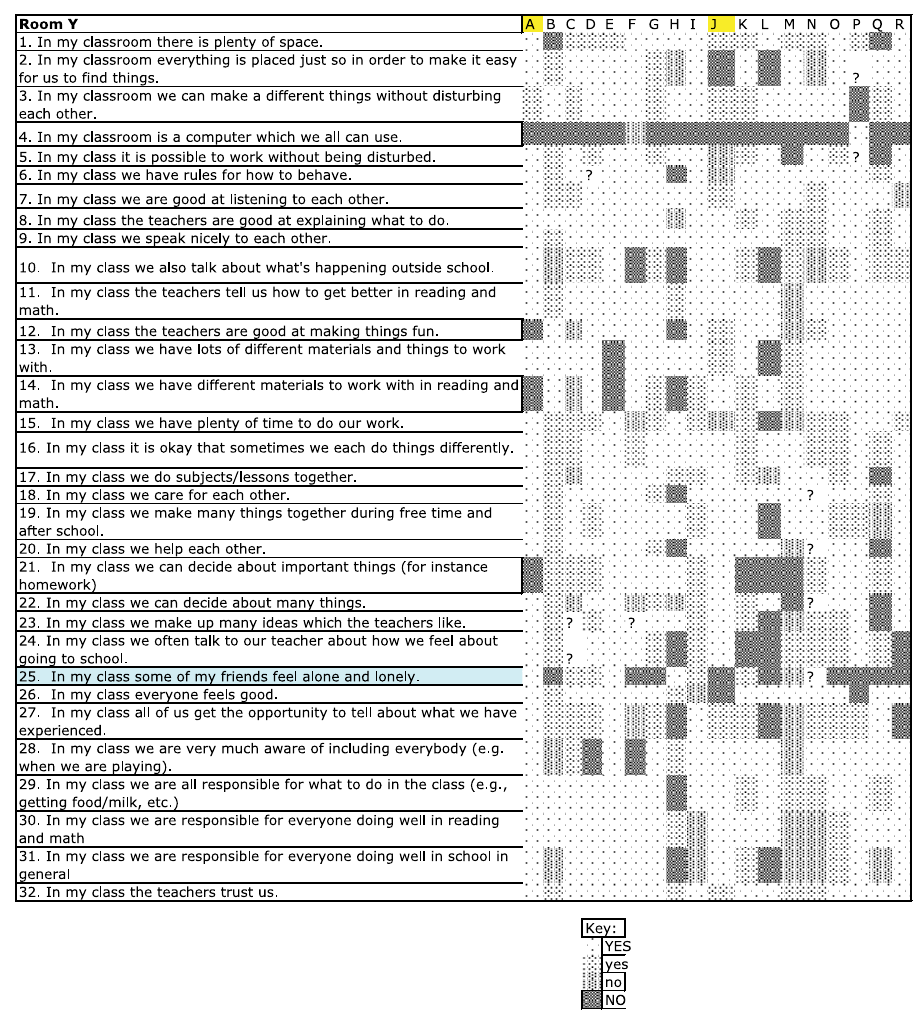
Figure 2. First graders perceptions of classroom